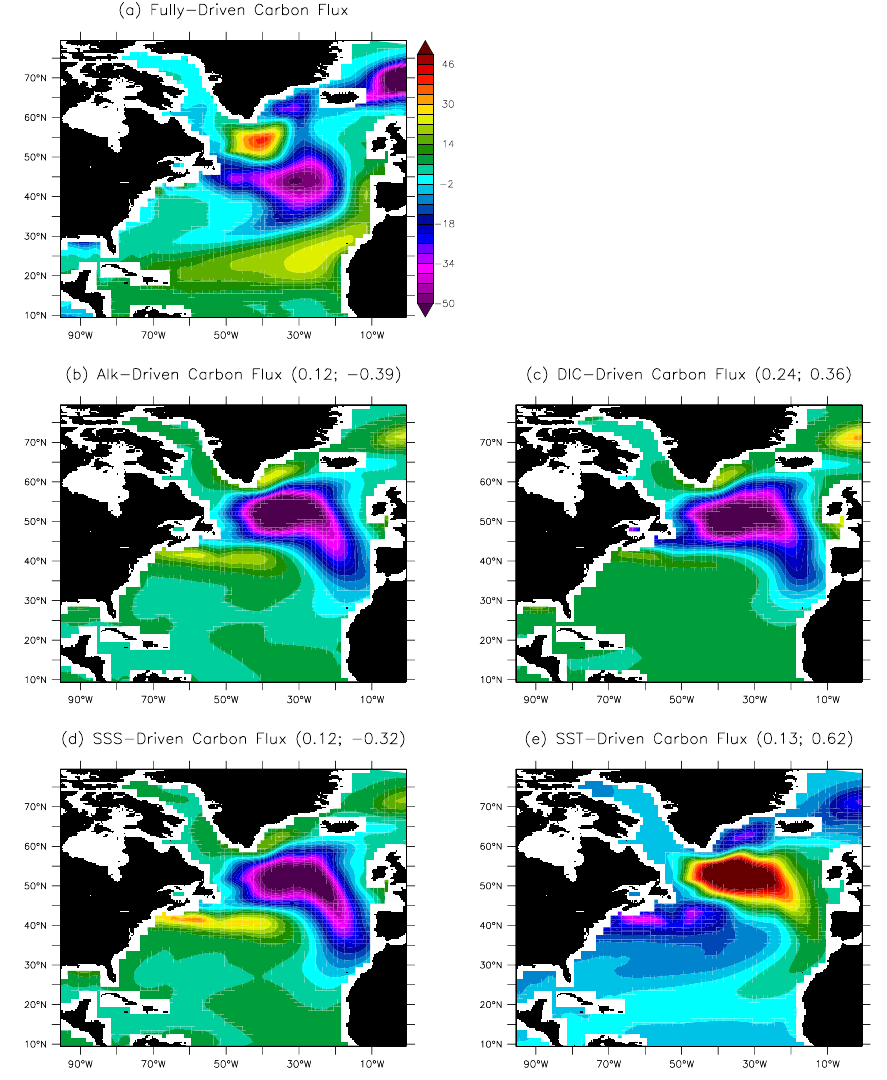
Fig. 5. Spatial pattern of the leading empirical orthogonal function (EOF, in normalised unit) of (a) the fully-driven carbon fluxes, and that of the Alk-driven (b) , DIC-driven (c) , SSS-driven (d) and SST-driven (e) ocean carbon fluxes in the North Atlantic. Spatial correlations (based on EOFs) and temporal correlations (based on CPs) between the fully-driven ocean carbon fluxes and each driver-related carbon fluxes are mentioned in